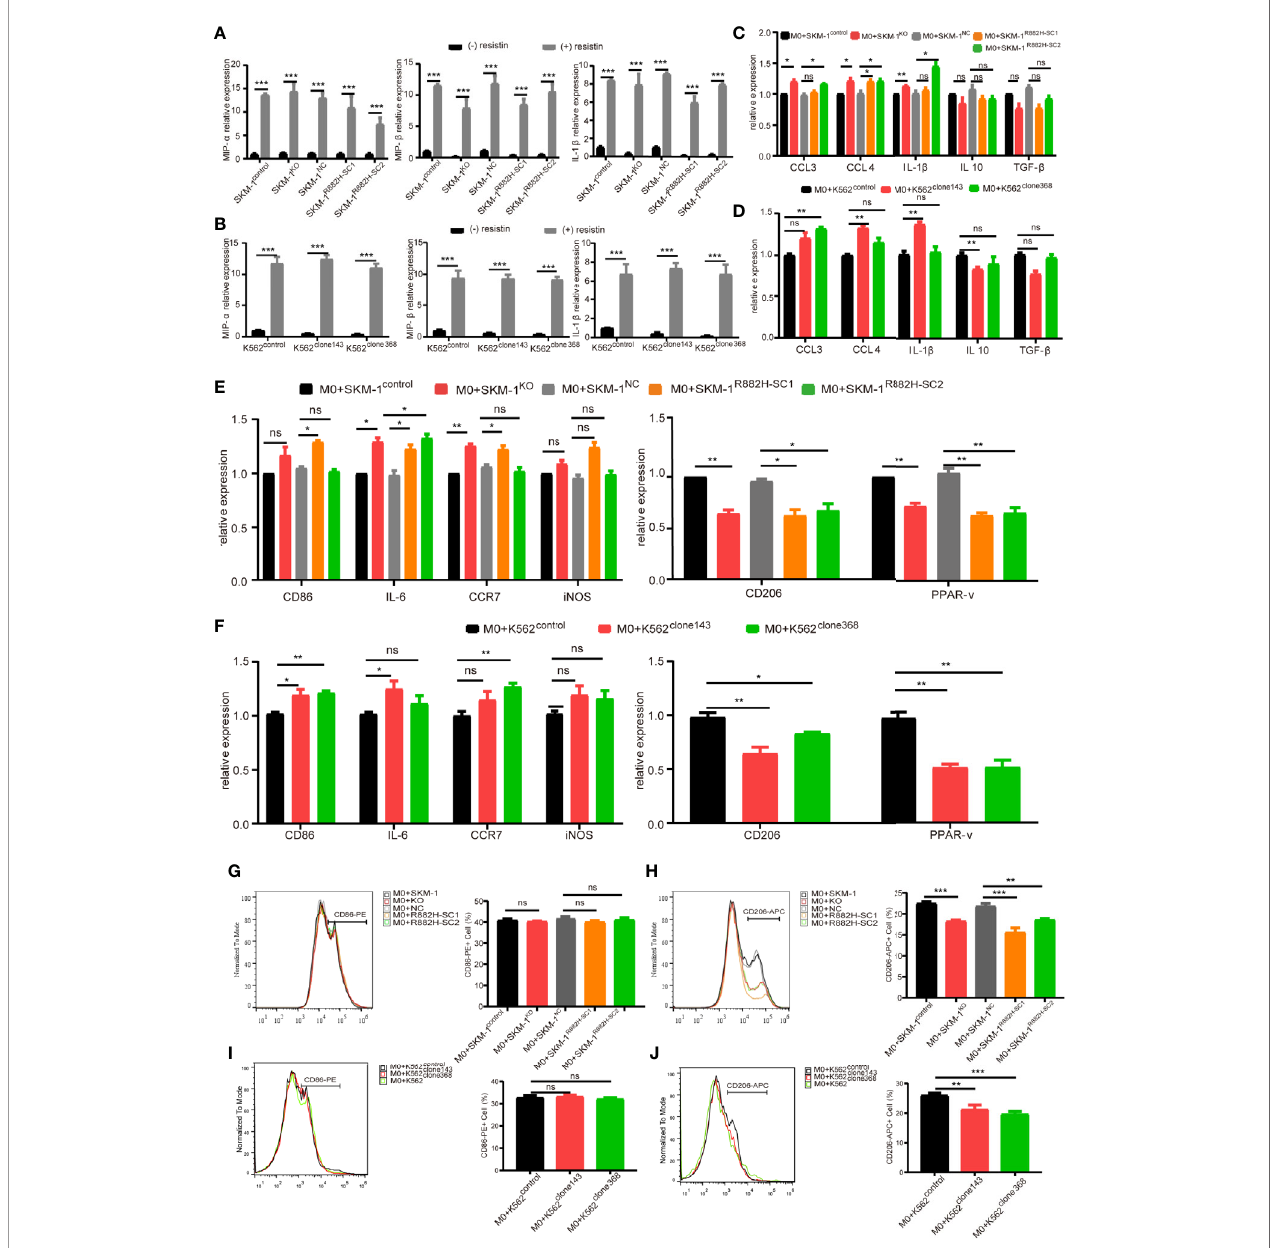
FIGURE 6 | DNMT3A mutated AML cells regulate the macrophage phenotype by suppressing transcription factors AP-1. (A, B) The mRNA expression of MIP-1 a , MIP-1 b , IL-1 b was measured by qRT-PCR in SKM-1 cells and K562 cells after stimulation with resistin. (C, D) The mRNA expression of MIP-1 a , MIP-1 b , IL-1 b (pro- in fl ammatory factors) and TGF- b , IL-10 (immunosuppressive factors) was measured using qRT-PCR in SKM-1 cells and K562 cells treated with resistin after co- cultured with macrophages. (E, F) The mRNA expression of CD86 , IL-6 , iNOS , CCR7 (M1 marker) and CD206 , PPAR- g (M2 marker) was measured using qRT-PCR in macrophages after the co-culture with AML cells treated with resistin. (G – J) The expression of CD86 and CD206 in macrophages after the co-culture with AML cells treated with resistin was analyzed using fl ow cytometry. The histogram is a statistical graph of the fl ow chart. *p < 0.05, **p < 0.01, and ***p < 0.0001. ns, no signi fi